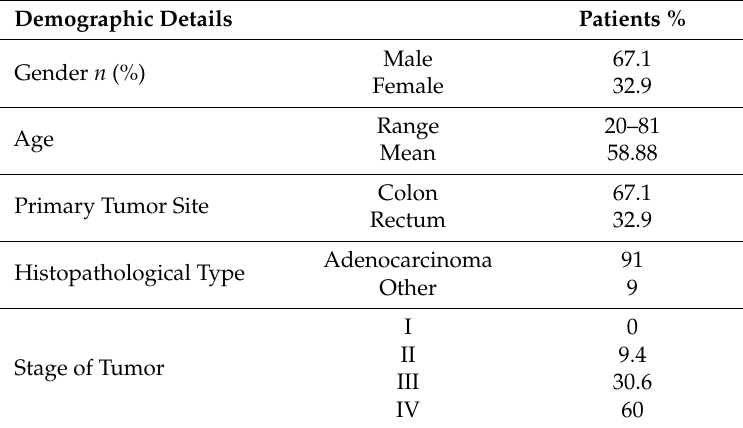
Table 1. Patient characteristics of the study